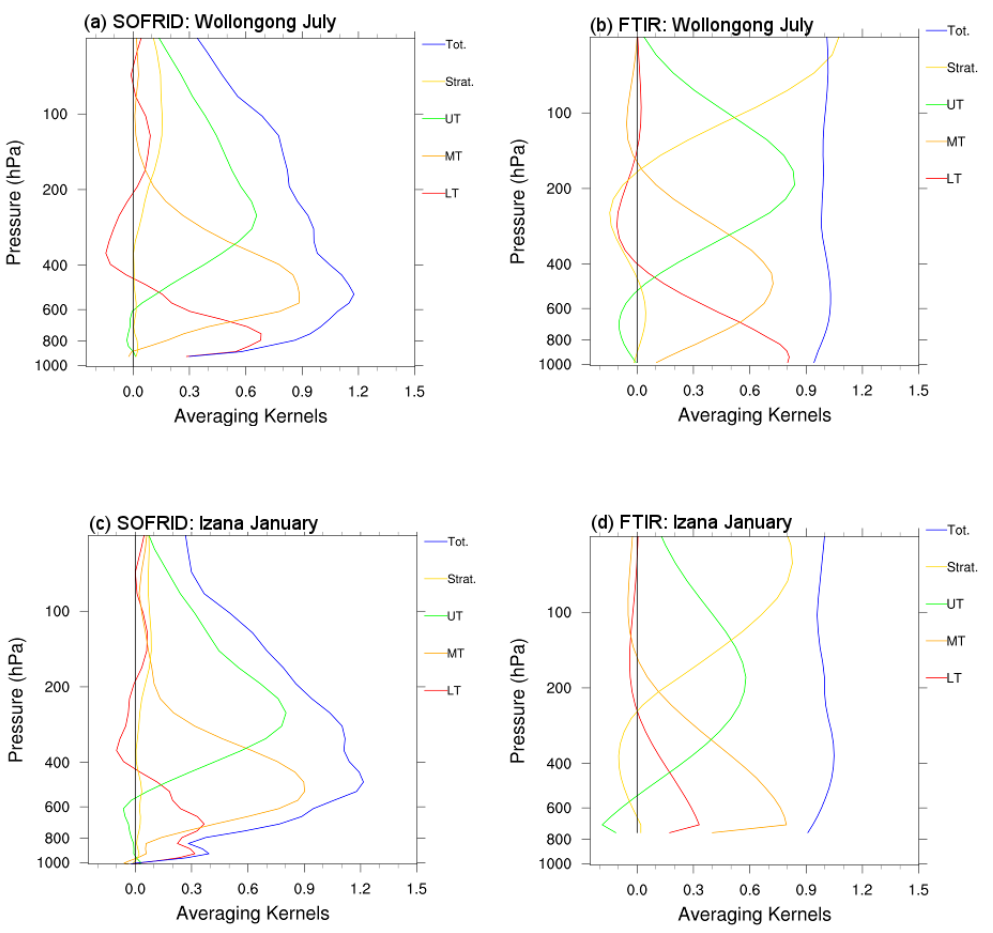
Figure 3. N 2 O averaging kernels for ( a ) IASI in Wollongong in July ( b ) NDACC in Wollongong in July ( c ) IASI in Izana in January ( d ) NDACC in Izana in January. Total Column (Tot), Lower Troposphere (LT, 1013–700 hPa), Middle Troposphere (MT, 700–350 hPa), Upper Troposphere (UT, 350–110 hPa) and Stratosphere (Strat., 100–10